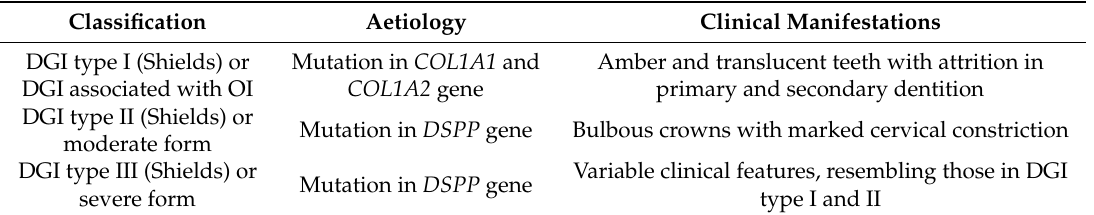
Table 1. Overview of classification for DGI disorders including aetiology and clinical